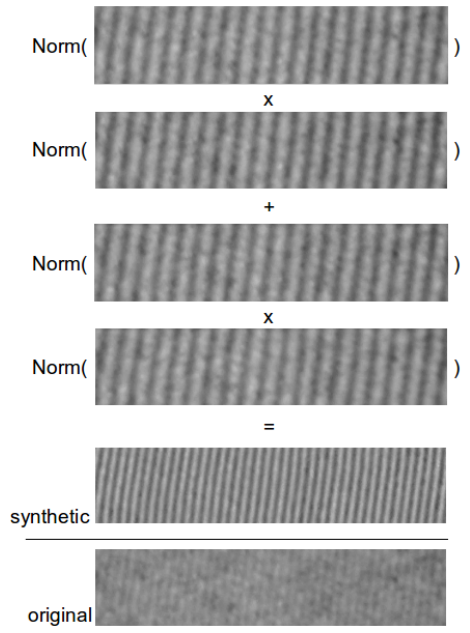
Figure 8: Image details to demonstrate synthesis of a finest- striped image (5th from above) from four courser ones (upper four). At the bottom the finest-striped image is shown as recorded by the camera.